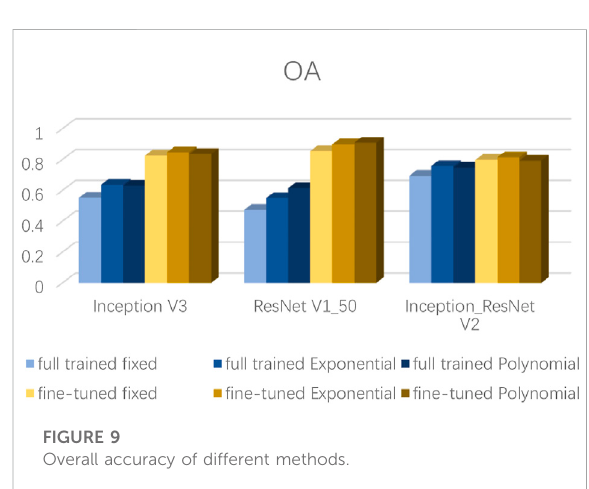
FIGURE 9 Overall accuracy of different